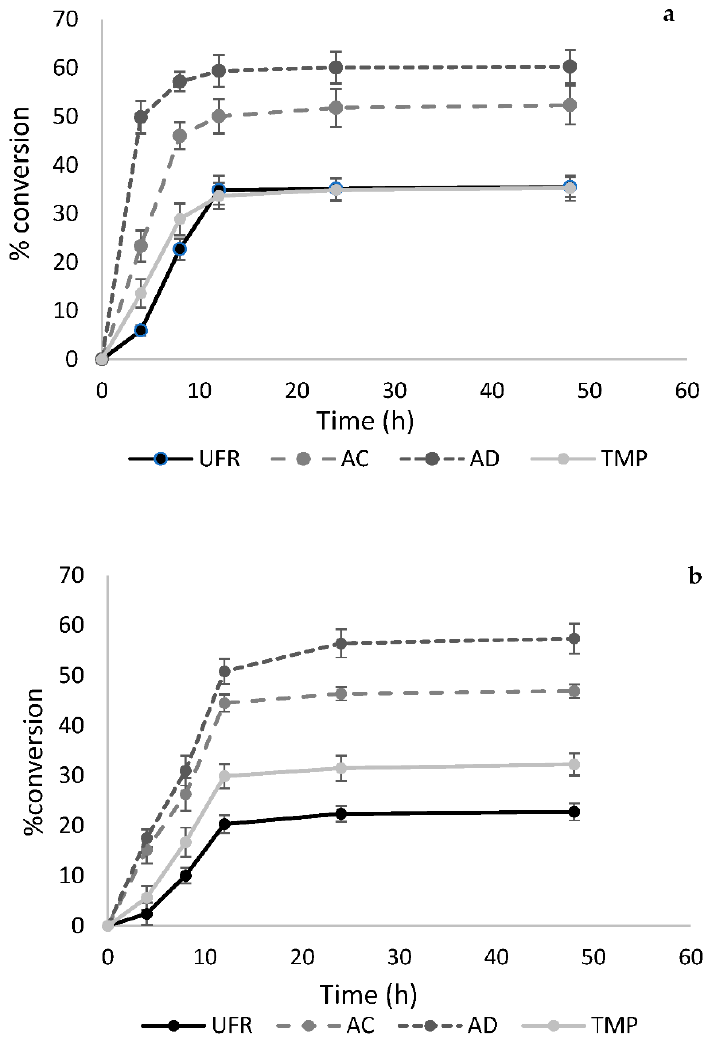
Figure 2. Hydrolysis of different SSL-AcGGM preparations and TMP-AcGGM using ( a ) Tr Man5A ( b ) Viscozyme L. UFR, AC and AD SSL-AcGGM preparations, and the TMP-AcGGM were used at an initial concentration of 100 mg/mL of GGM and both Tr Man5A and Viscozyme L at 0.1 mg/mL of protein (enzyme) loading. The hydrolysis reactions were carried out at 40 °C, pH 5.0 for 48 h. The reducing sugar equivalents were determined using the DNS method with a mannose standard curve and were reported as % conversion. The reactions were carried out in triplicate and mean values ± SD are presented.